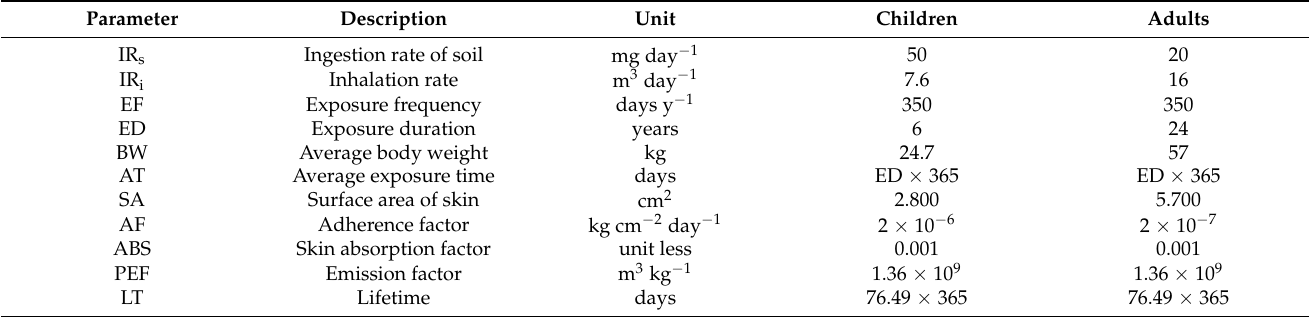
Table 2. Parameters utilized for the health risk assessment model and their values for children and adults